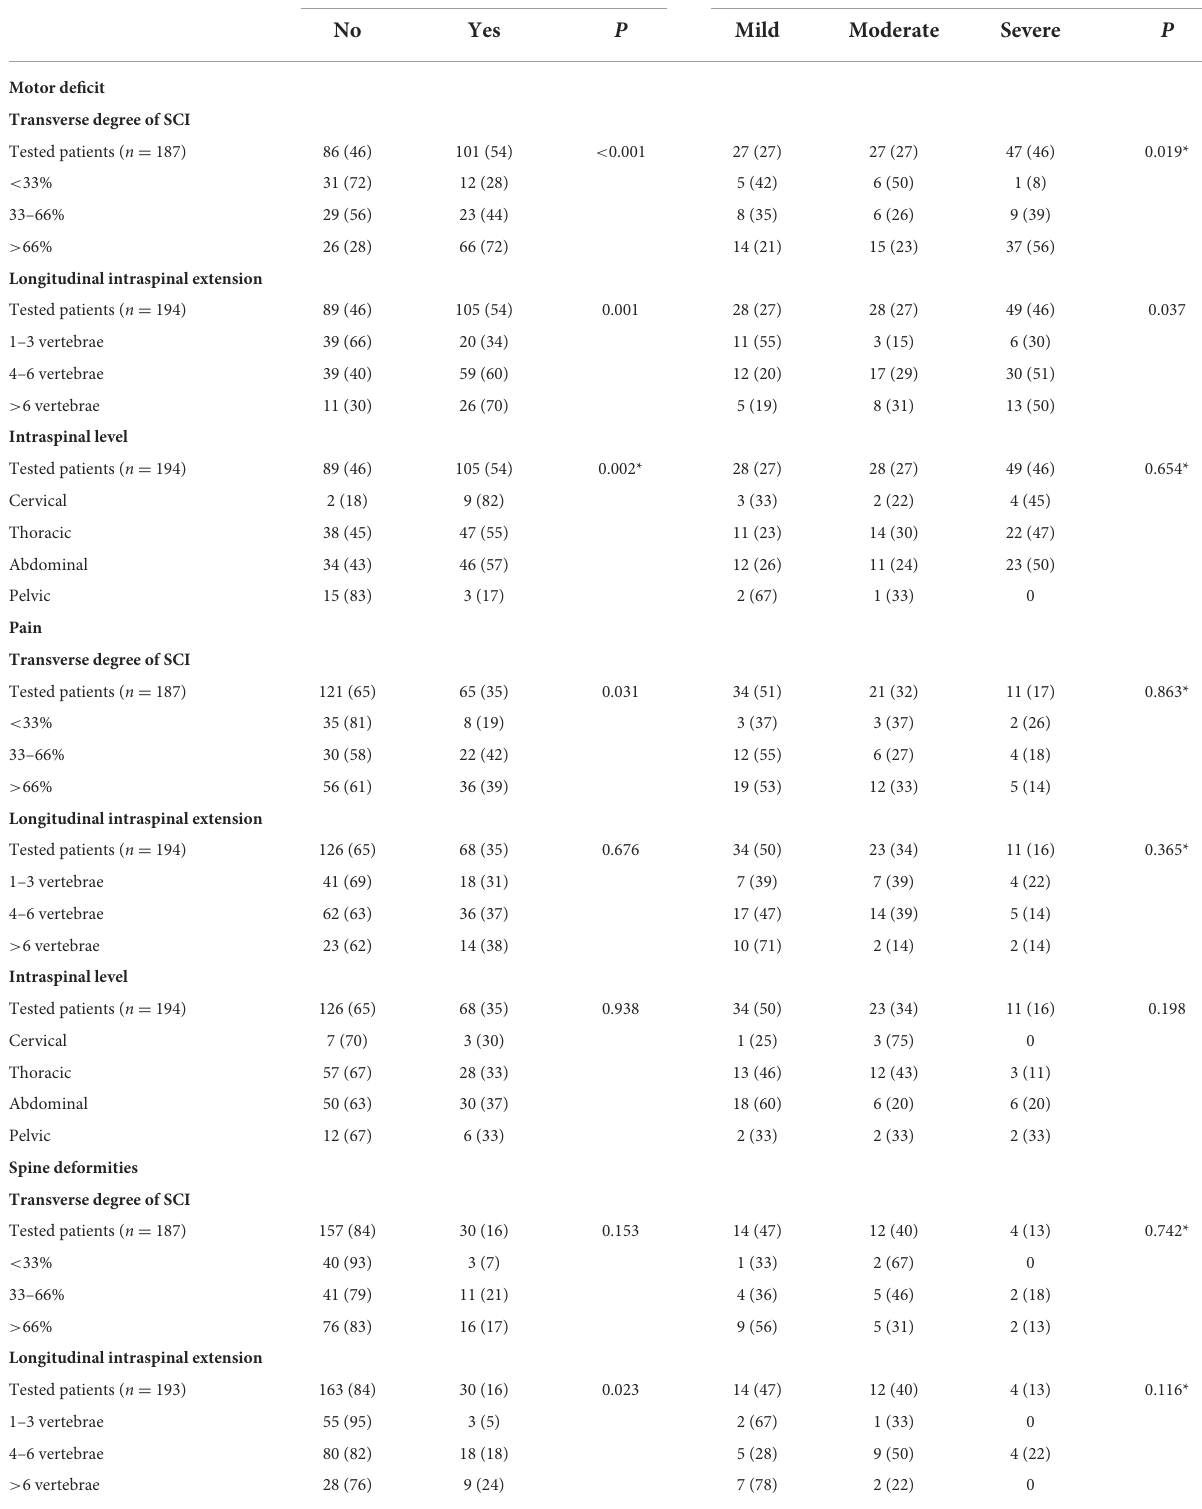
TABLE 6 SCI symptoms in relation to imaging